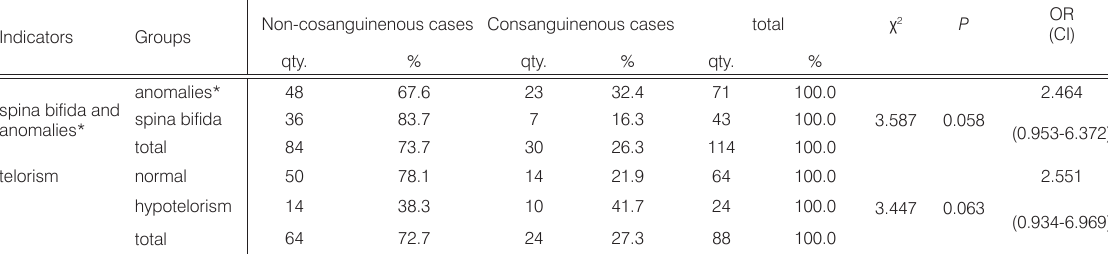
Table 2. Consanguinity and associated anomalies in fetuses with